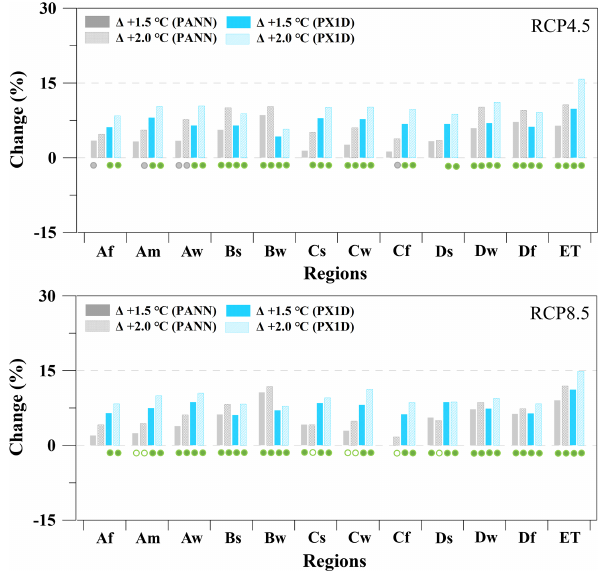
Figure 9. Relative changes in the annual mean precipita- tion (PANN) and PX1D for the 12 climate zones derived from the MME of the five GCMs under 1.5 and 2.0 ◦ C of global warming compared to the reference period (REF). Green circles (gray cir- cles) denote 100% (over 80%) intermodel